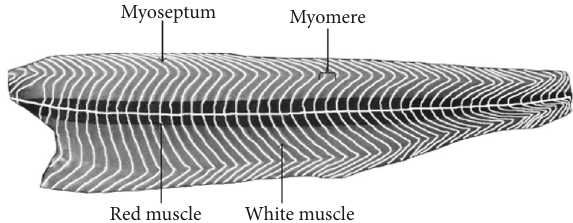
Figure 3: Salmon fish fillet in longitudinal section, beneath the skin, to present the W-shape of myomere and the two muscle types (Figure 3 is reproduced from [21] [under the Creative Commons Attribution License/public domain]).